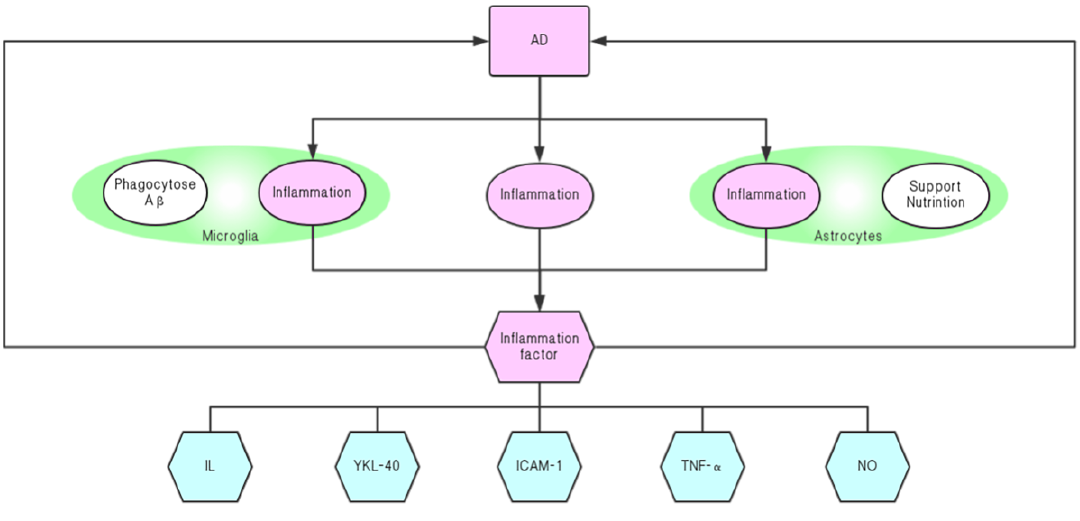
Figure 6. Mutual promotion of neuroinflammation and AD.